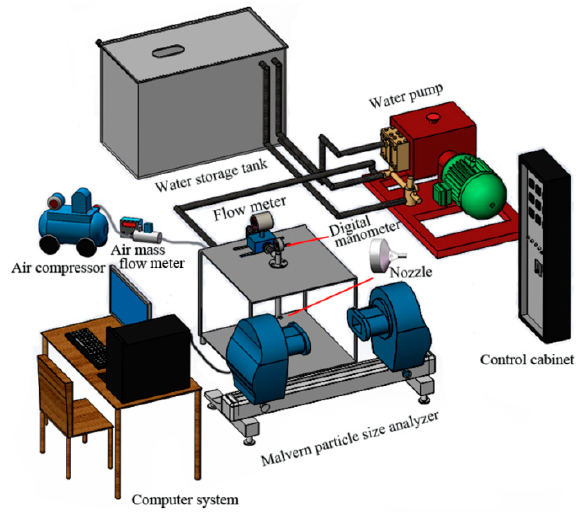
Figure 2. The experimental platform.